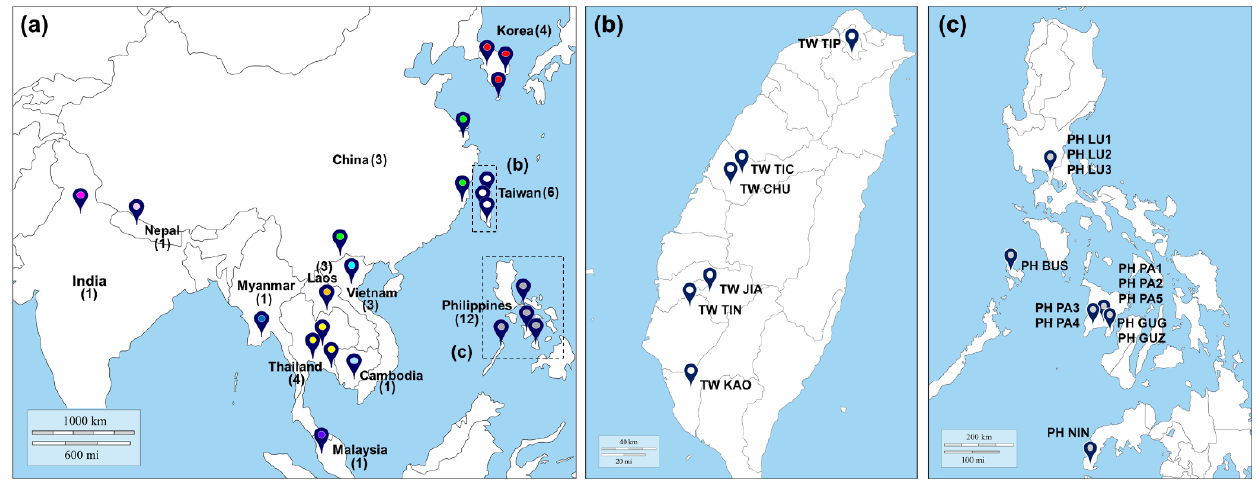
Figure 1. Sample collection sites of Bactrocera dorsalis in Southeast Asia. Map of Southeast Asia showing the B. dorsalis sample sites collected for this study. ( a ) East Asia map for sampling. Number of collections from each country indicated in parenthesis. ( b ) Collection area on Taiwan Island. ( c ) Collection areas on the Philippine Islands. Detailed location information is described in Supplementary Materials Table S1.